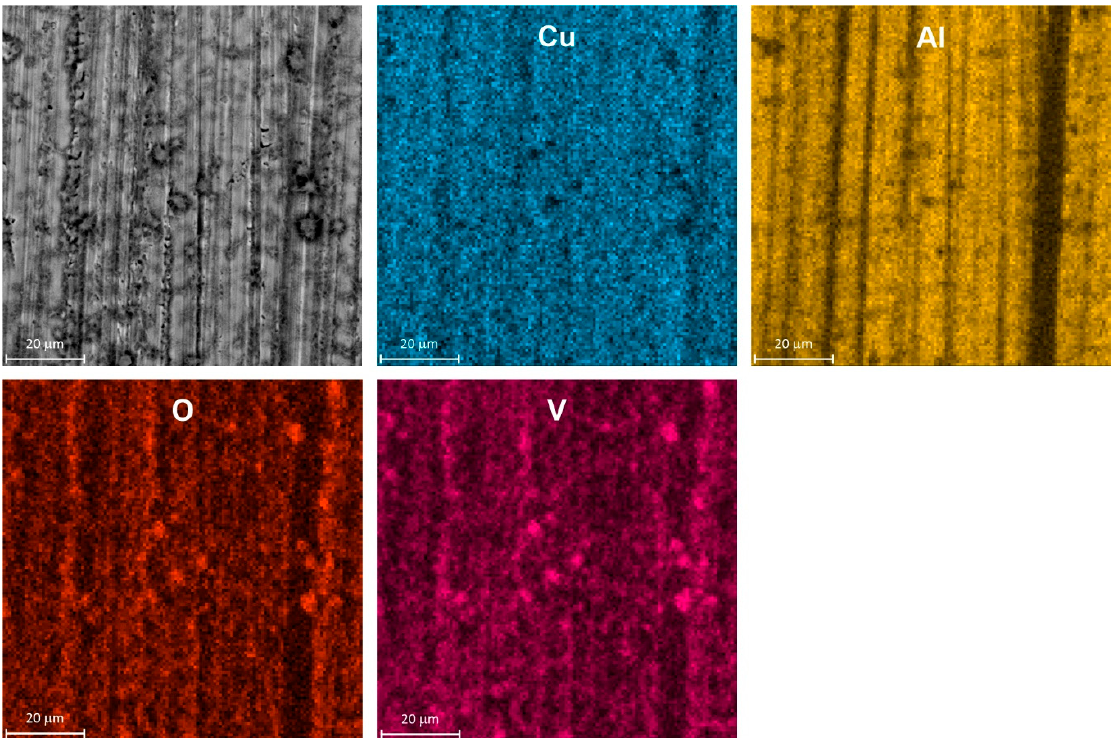
Figure 7. Micrograph of intermetallic Al 2 Cu after corrosion in H 2 SO 4 solution, c V = 100 mM, pH = 1.3, immersion time t = 576 min, T = 303 K together with spatial distribution of elements, color intensity differences on EDX maps occur due to different concentration of elements and are also related to height of the specimen.